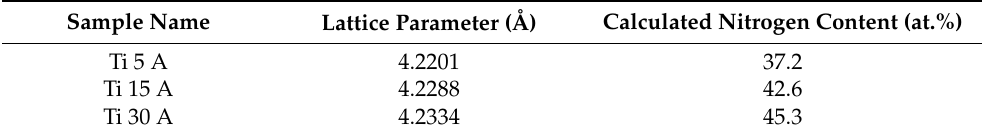
Table 3. Lattice parameter and nitrogen content of TiN